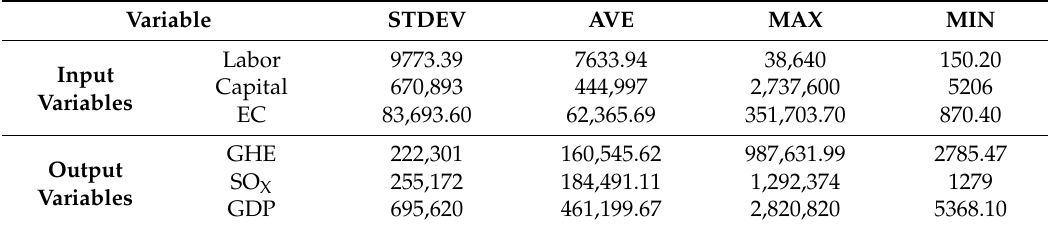
Table 3. Descriptive statistics of input and output variables.